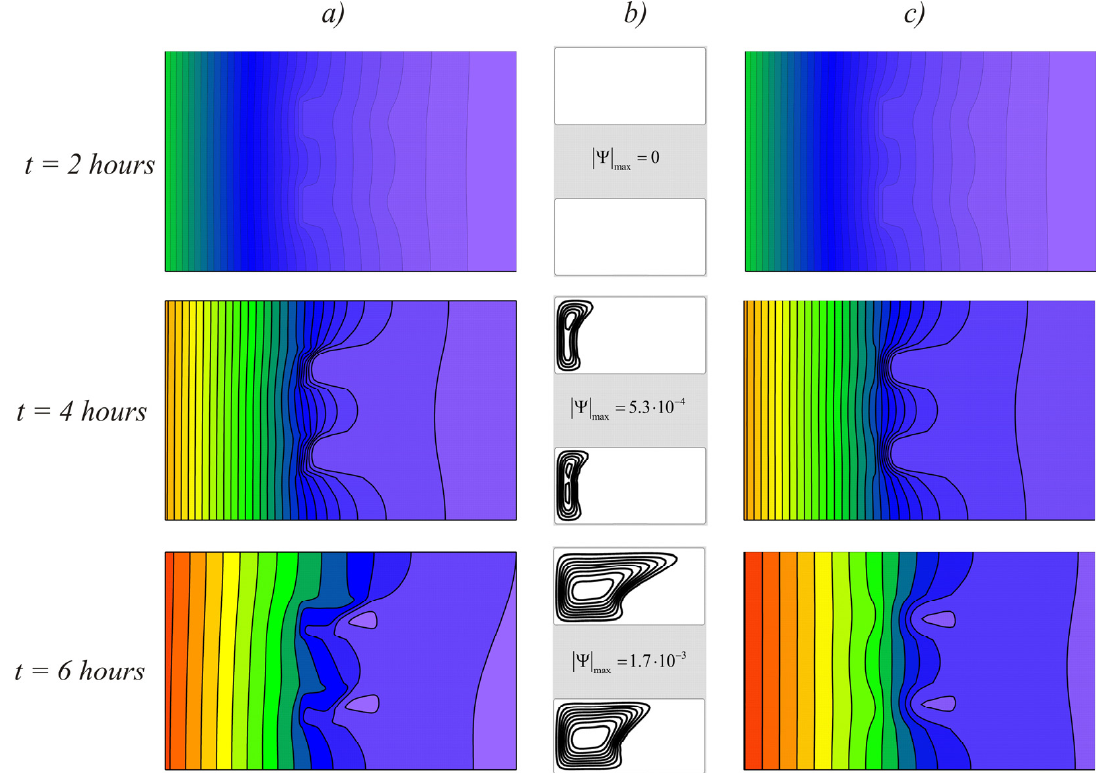
Figure 4. Temperature fields ( a ) and streamlines ( b ) for the case L = 0.01 and ∆ T = 10 taking into account natural convection in the melt and temperature distributions obtained without natural convection ( c ) at different